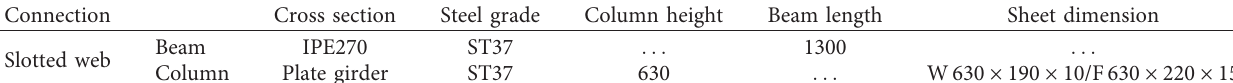
Figure 11: SW geometry (units in Table 2: Modelled subassembly (units in mm).